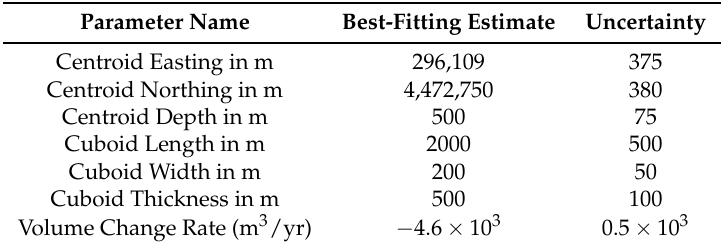
Figure 3. Histogram of differences in the eastward component of velocity gradient fields estimated from SqueeSAR and minimum spanning tree (MST) for all three interferometric synthetic aperture radar (InSAR) data sets. Differences are shown in terms of strain rate (picostrain per second). Table 5. Best-fitting estimates of a single cuboidal sink model after simulated annealing on unwrapped range change rates from ENVI T27 SqueeSAR